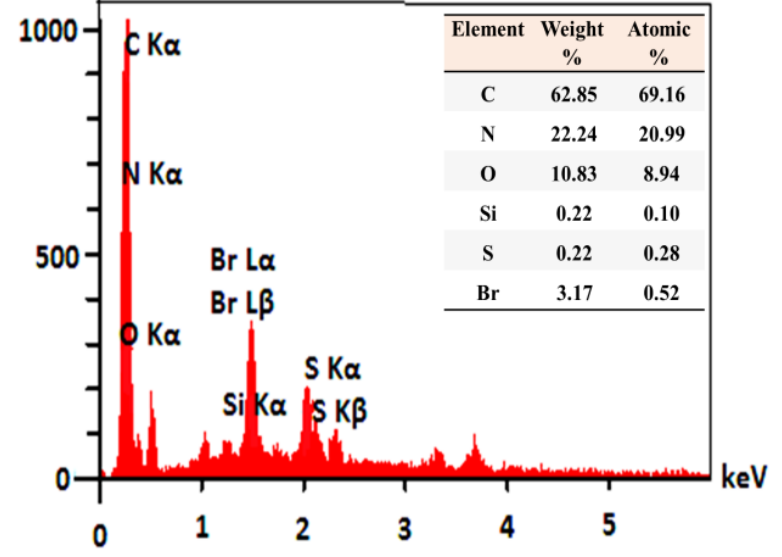
Figure 3. EDS analysis of BC@GCN-P-IL.